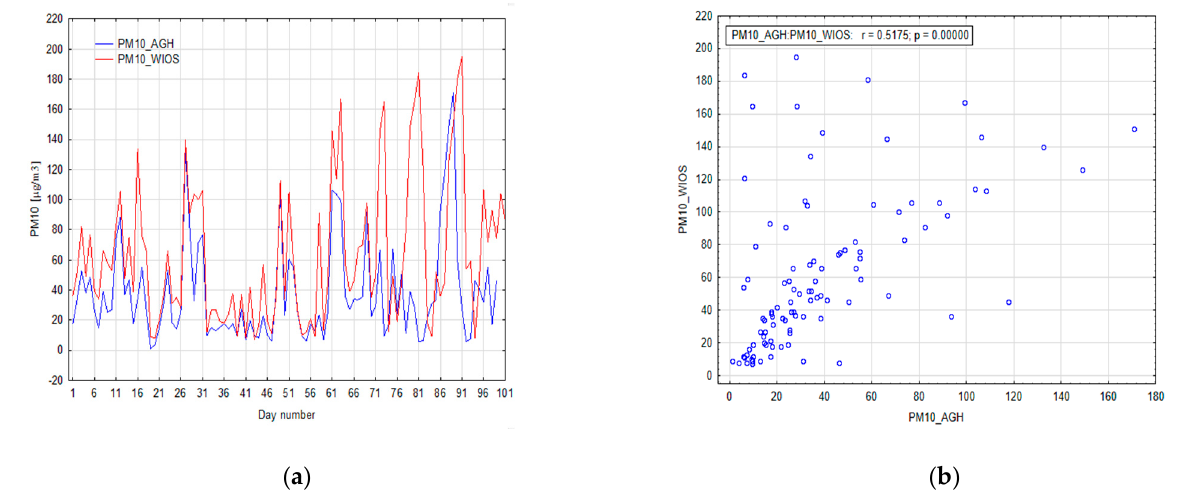
Figure 6. Correlation between AGH and WIOS stations for PM10: ( a ) time series comparison, ( b ) correlation plot.